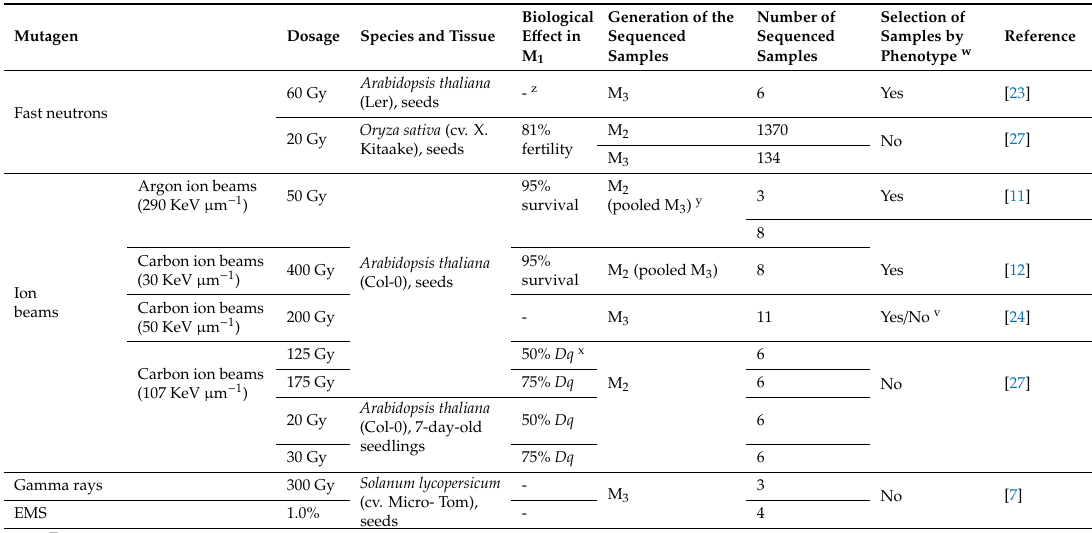
Table 1. Investigations in which mutagen characteristics were analyzed based on the whole-genome sequencing of mutant samples. EMS: ethyl